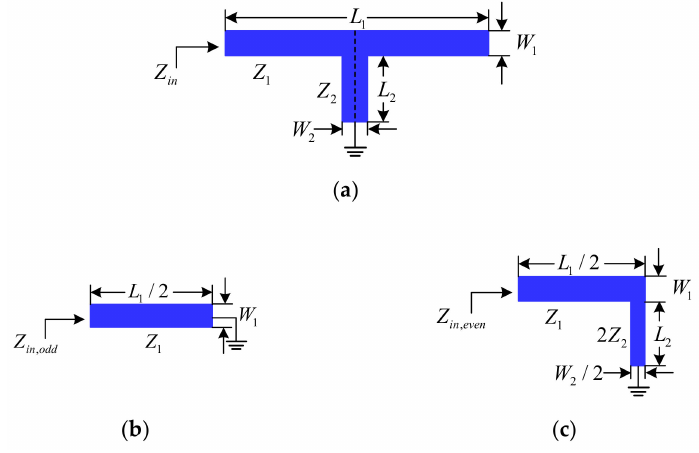
Figure 2. Schematic of the conventional dual-mode short-circuit stub-loaded resonator: ( a ) dual-mode resonator; ( b ) odd-mode; and ( c ) even-mode.